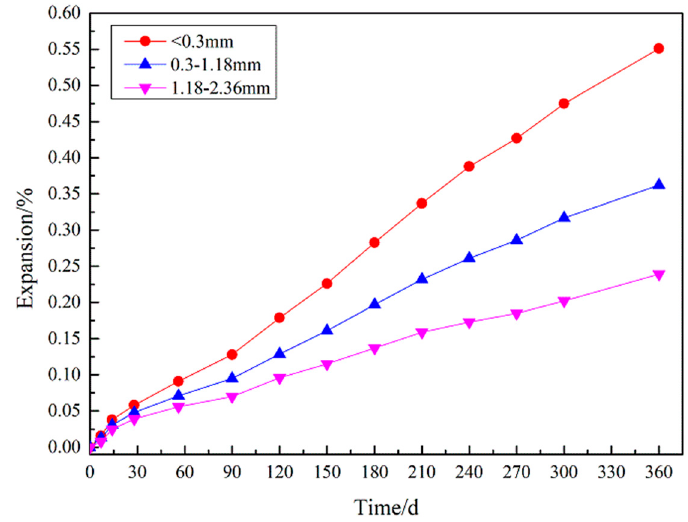
Figure 12. XRD patterns of mortars with different sizes of gypsum